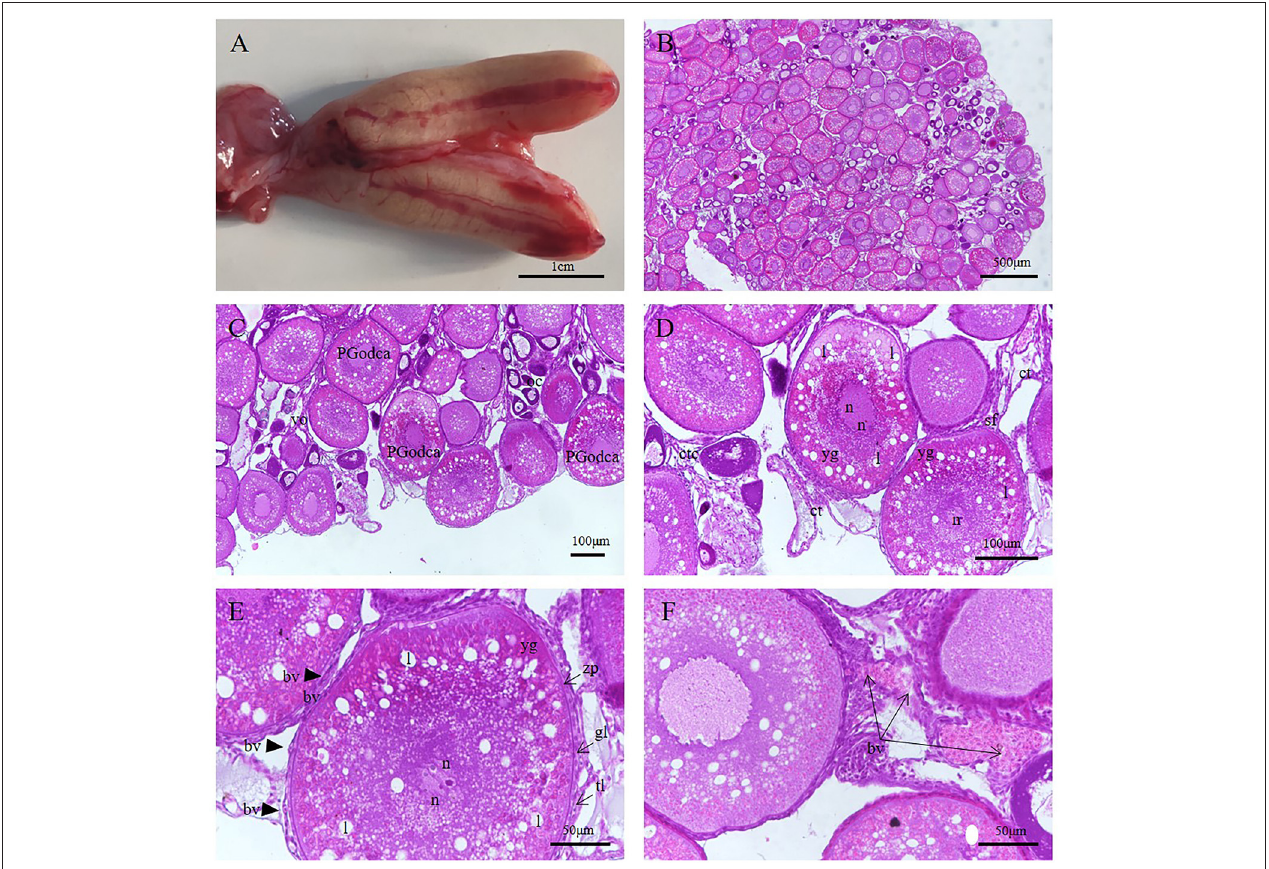
FIGURE 7 | S. schlegelii , oocytes during non-gestation. (A) Anatomical structure of the ovary. (B) The follicular cells hang on the villi ovarialis (vo) and form grape like structure. (C) The villi ovarialis (vo) were distributed along the ovarian cavity (oc), and the oocytes in different developmental stages were surrounded by follicular cells, mainly III phase oocytes, also called the primary and secondary growth stages oil droplet-cortical alveoli oocytes (PGodca). (D) Follicular cells hang on the villi ovarialis (vo) through the stalk of the follicle (sf). (E) III phase oocytes. There were small yolk granules (yg) were present in the cytoplasm near the inner edge of the plasma membrane and some small lipids (l) appeared around the nucleus (n) of the oocyte. The follicles are composed of oocytes and follicular cells. The follicular cells include a granulosa layer (gl) and thecal layer (tl), these are located outside the zona pellucida (zp), and there are blood vessels (bv) are present in the thecal layer(tl). (F) Blood vessels (bv) and connective tissue (ct) of villi ovarialis (vo). Scale bars, 1cm (A) ; 500 µ m (B) ; 100 µ m (C,D) ; 50 µ m (E,F) . HandE